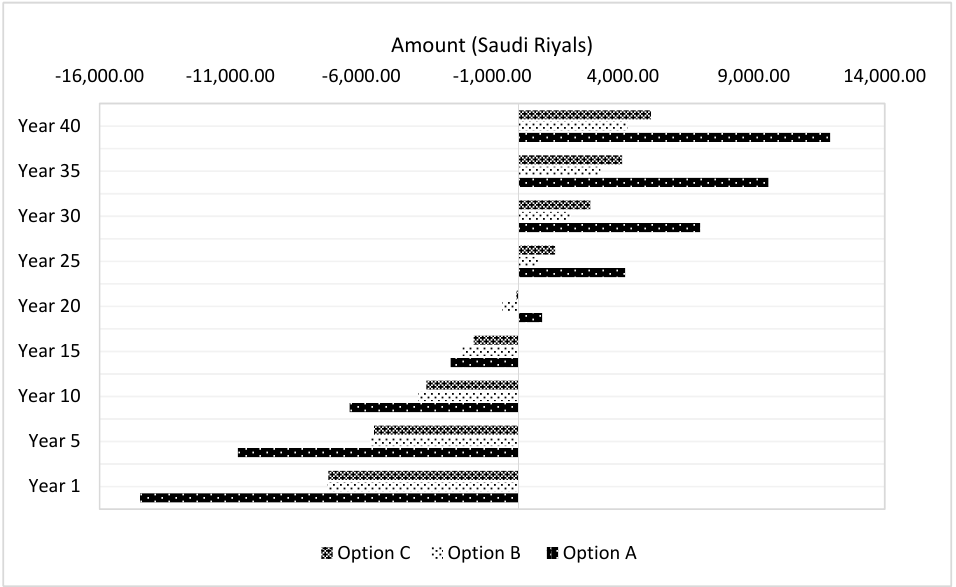
Figure 6. Yearly Net Present Value ( NPV) for the green roof options (Saudi Riyals).